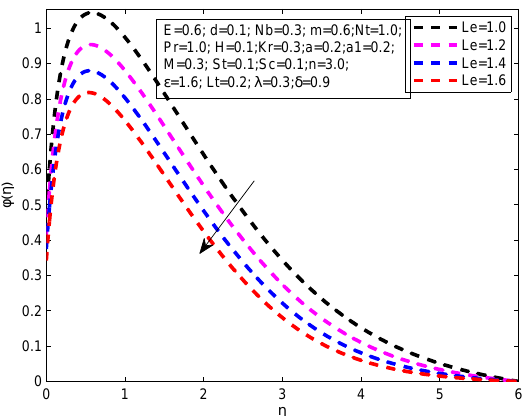
Figure 14. Variation of φ for distinct values of Le .